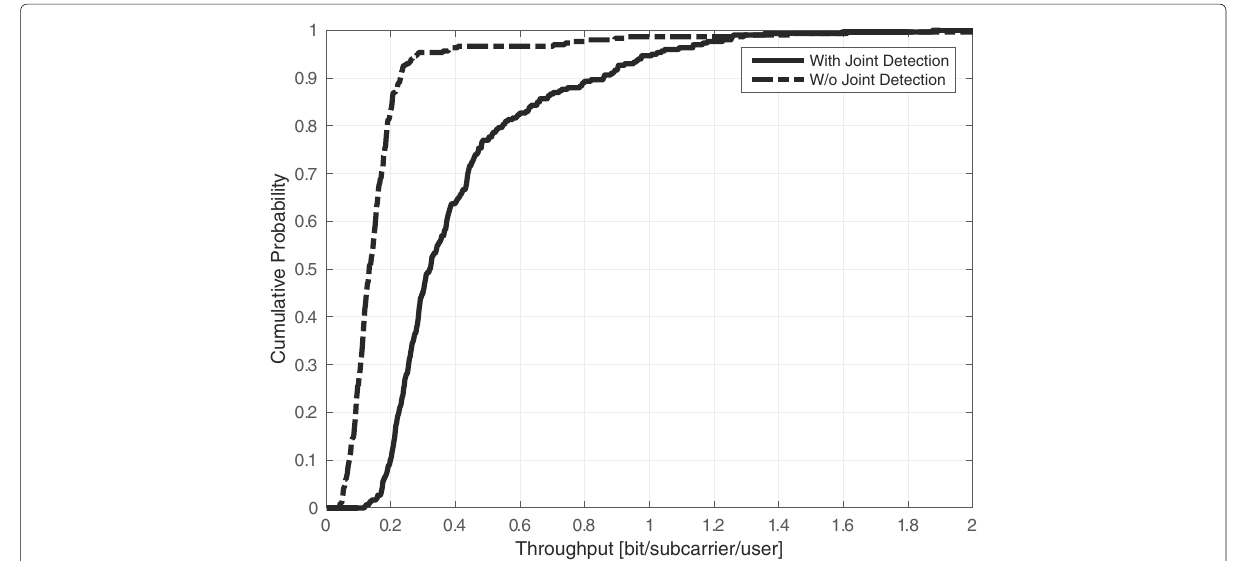
Fig. 4 Total system throughput performance (10